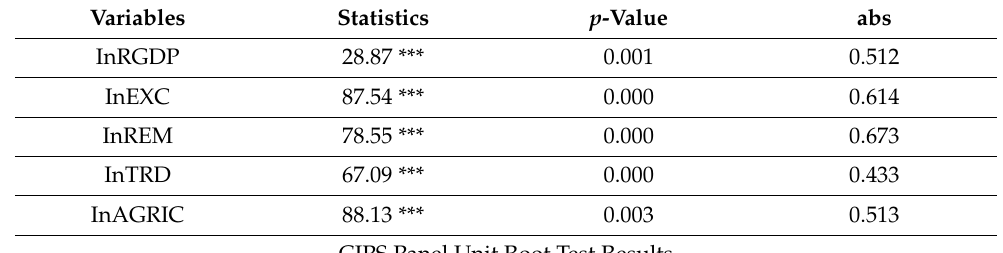
Table 1. Cross-sectional dependence and unit root test results.